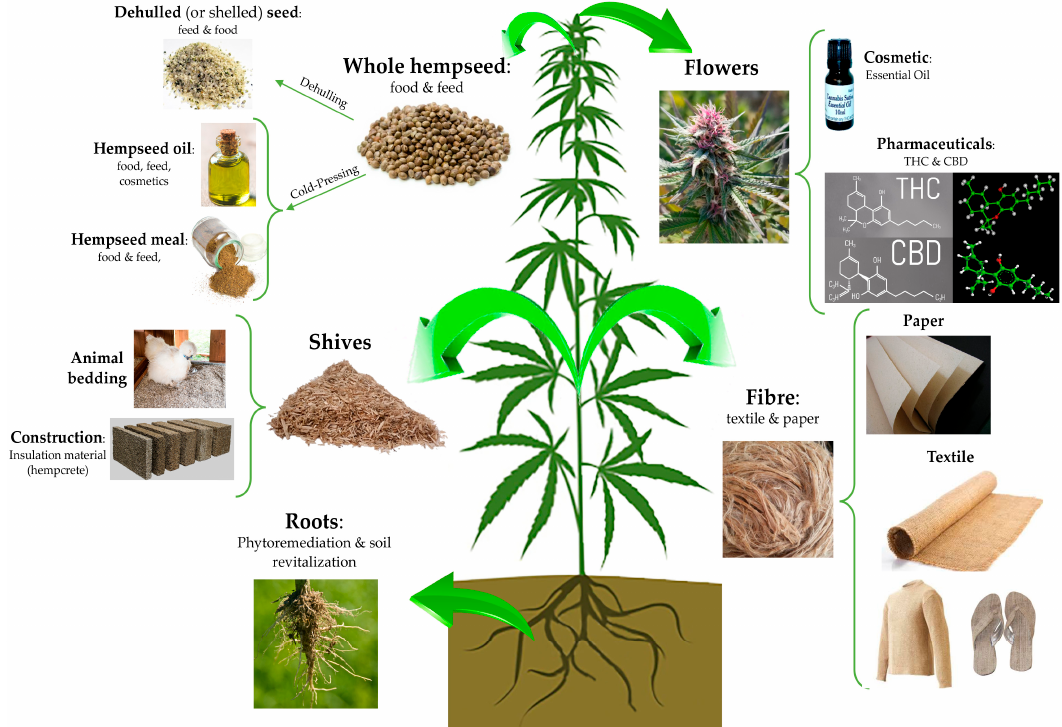
Figure 1. The manifold applications of hemp plant: virtually, each part of this plant can be used in a specific industrial field. The seeds can be used in the food, feed, and cosmetical field as whole or dehulled, or it may be subjected to a cold press process to obtain an oil used in the food and cosmetic industries. From the stem, it is possible to obtain both shives and fibre, useful for animal, building, paper and textile applications. The hemp root system is highly developed in comparison to other herbaceous plants, and this feature is suitable for the phytoremediation of soil from heavy metals. Hemp flowers can be used for ornamental purposes or to obtain products of cosmetic and pharmaceutical interest, such as essential oils composed by delta-9-tetrahydrocannabinol (THC) and cannabidiol (CBD) pure extracts.